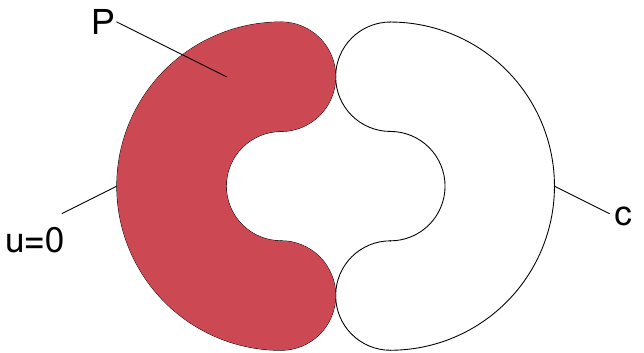
Figure 1 . Illustration of the (cid:12)bers at a 1 = b 1 = 0 loci for the P 2 form of the (cid:12)brations. The (cid:12)ber splits into two components. One component is given by u = 0, and the other is denoted as c . The zero section P wraps the u = 0 component of the (cid:12)ber, indicated by the (cid:12)lling of the u = 0 component in the